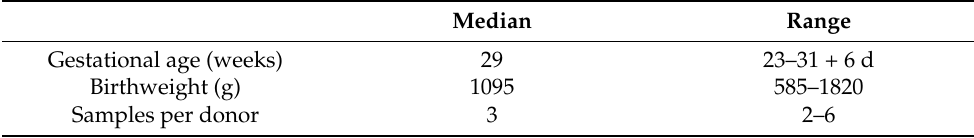
Table 1. Summary of basic demographic features and sampling from 51 preterm babies.